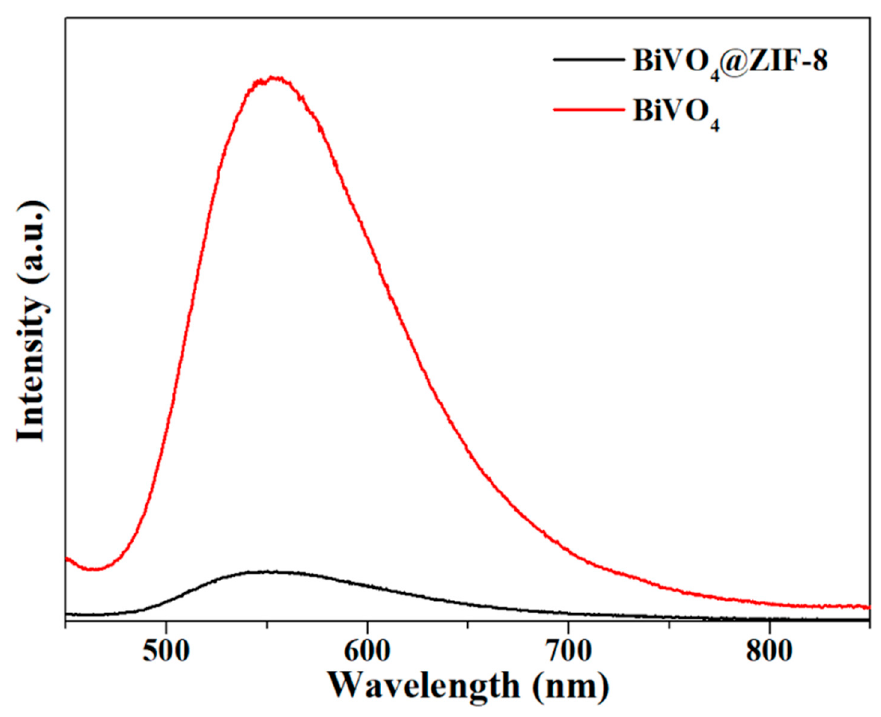
Figure 6. The PL spectrum of BiVO 4 and BiVO 4 @ZIF − 8; the PL intensity of BiVO 4 @ZIF − 8 is much weaker than that for pure BiVO 4 .